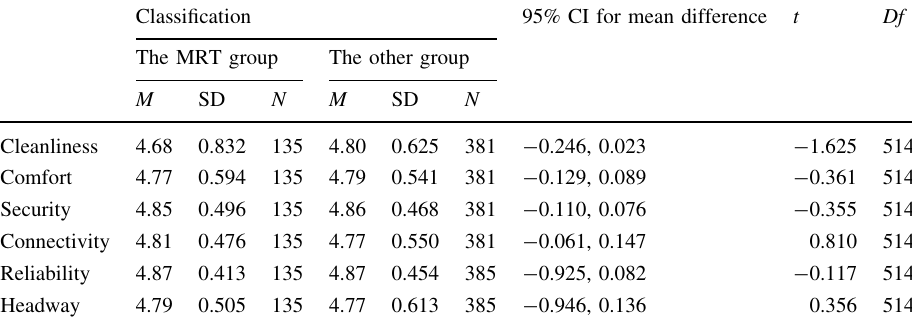
Table 3 Results of t test for the expectation questions by